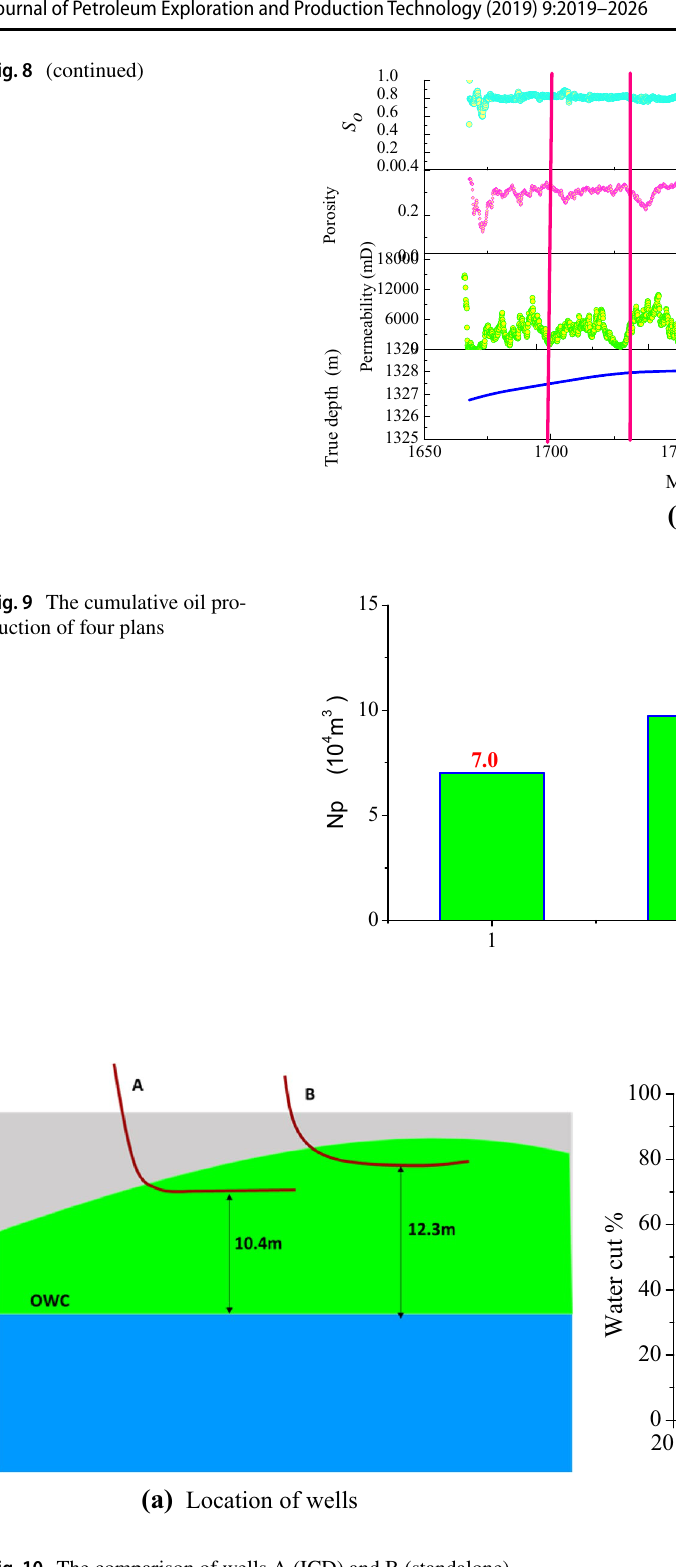
Fig. 10 The comparison of wells A (ICD) and B